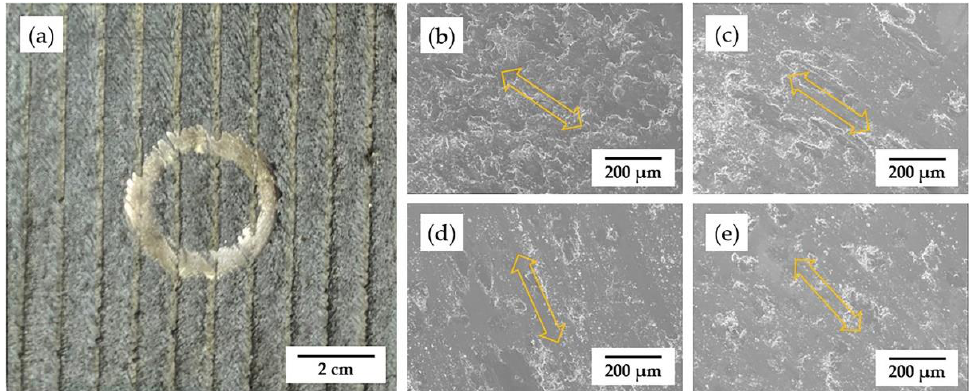
Figure 11. Surface morphology of the coatings after friction and wear test: ( a ) overview; ( b ) without HT; ( c ) 450 °C for 2 h; ( d ) 650 °C for 2 h; ( e ) 850 °C for 2 h.